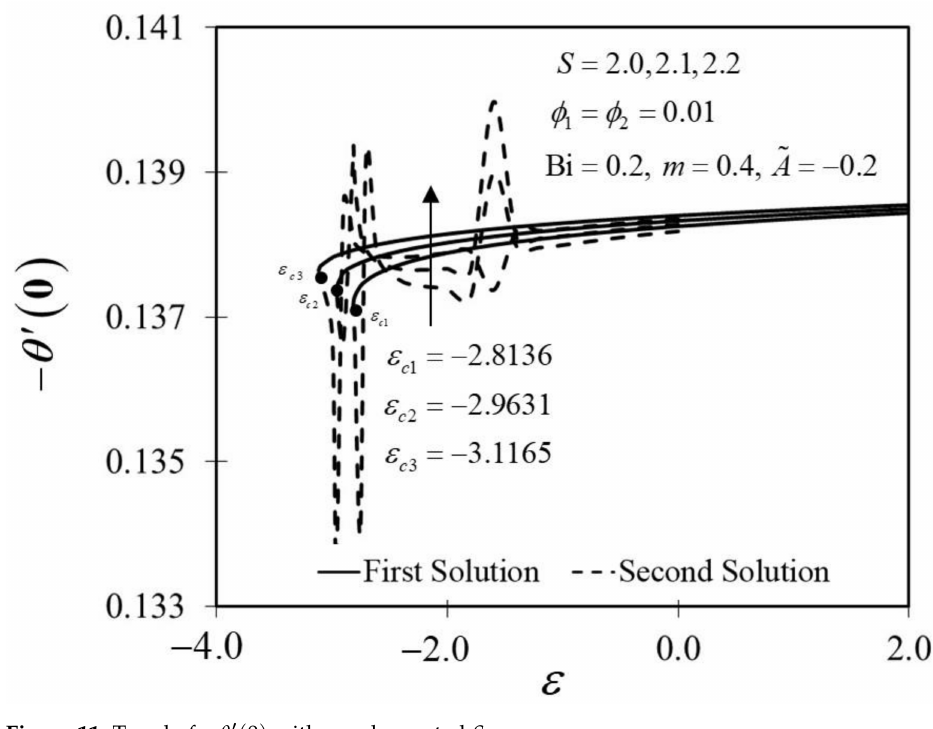
Figure 11. Trend of − θ (cid:48) ( 0 ) with ε and assorted S .